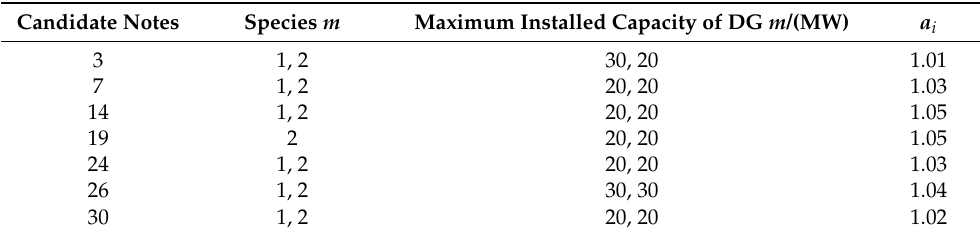
Table 1. Candidate notes for the species and maximum capacity of DGs.